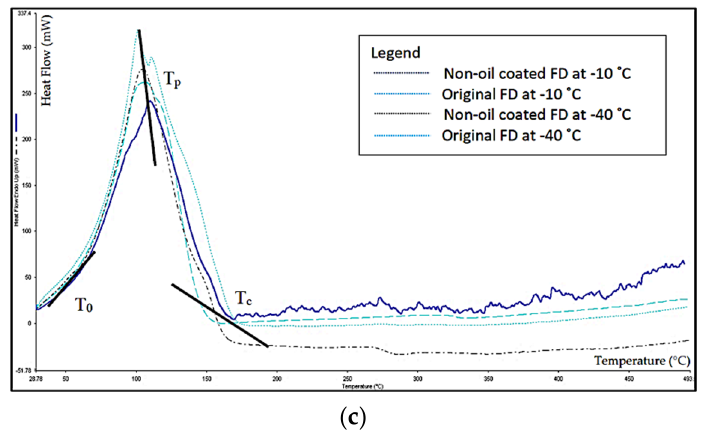
Figure 3. DSC results on starch gelatinization of ( a ) HAD ( b ) HPD and ( c ) FD of rice noodle. The starch gelatinization behaviour can be described by lines of different colours which represented the drying procedures.